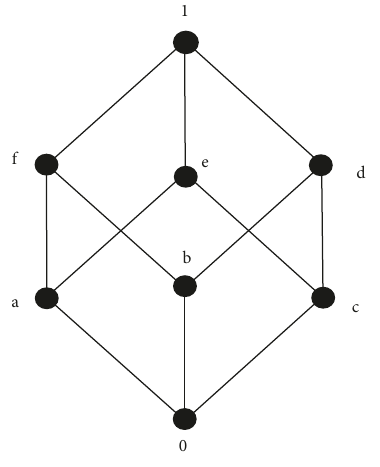
Figure 2: Lattice L � 0 , 1 ,a, b,c, d, e, f 􏼈 􏼉 . Table 2: Linear code over